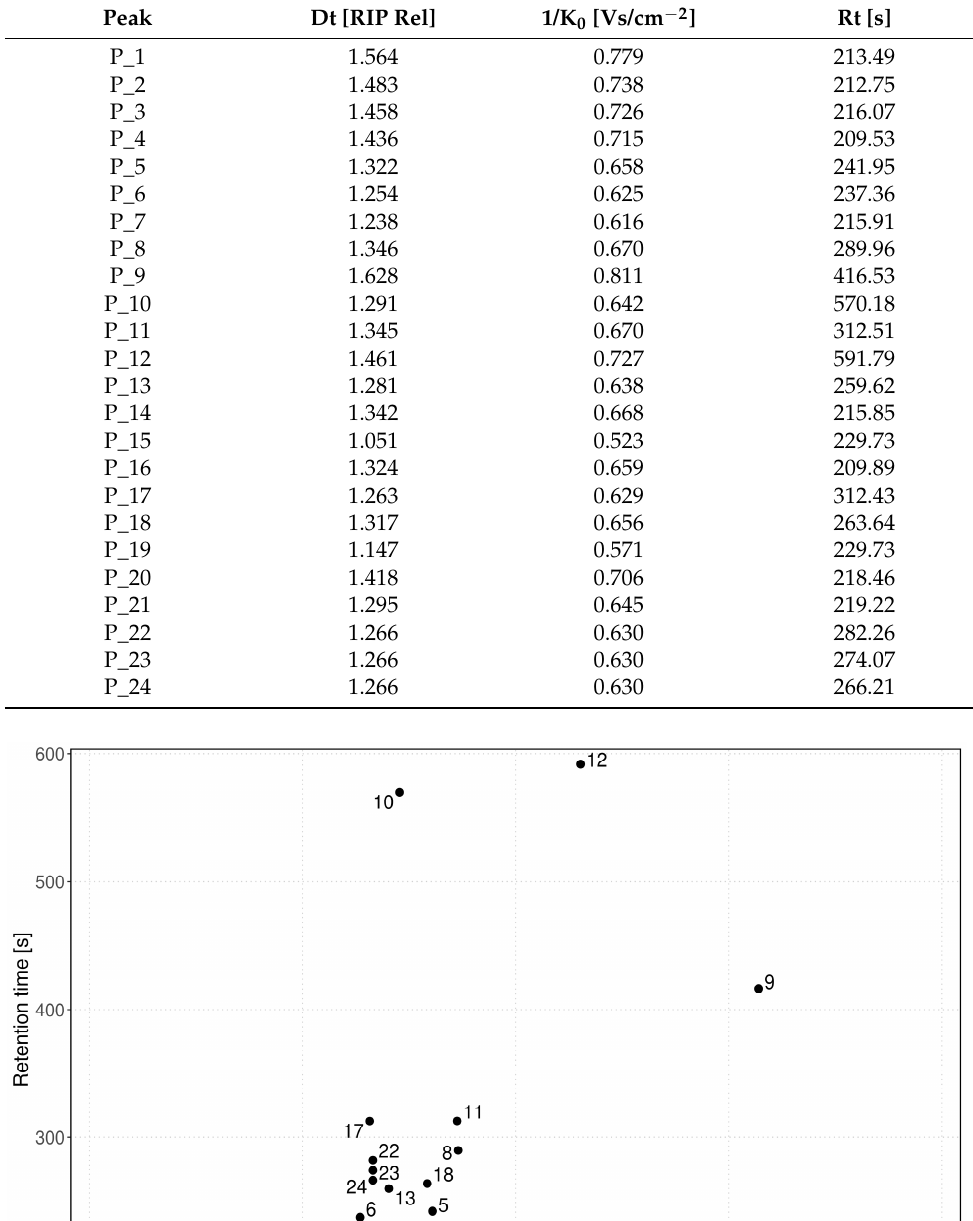
Table 1. List of mVOC detected by GC-IMS in the headspace of the EC group blood cultures. IMS drift time (Dt [reactant ion peak relative]); additionally, the inverse mobility (1/K 0 ) and GC retention time (Rt) are displayed.